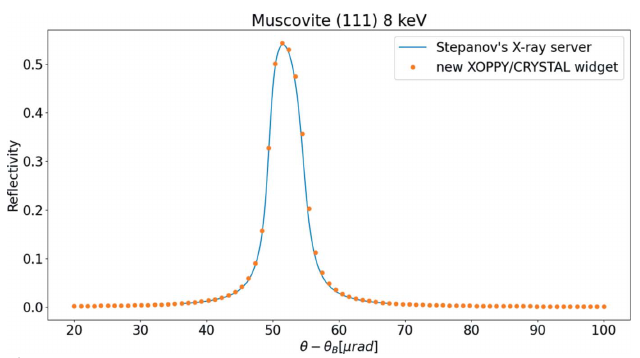
Figure 4 Comparison of crystal profile calculations of mica 111 at 8 keV using the new code (circles) and Stepanov’s X-ray server (solid